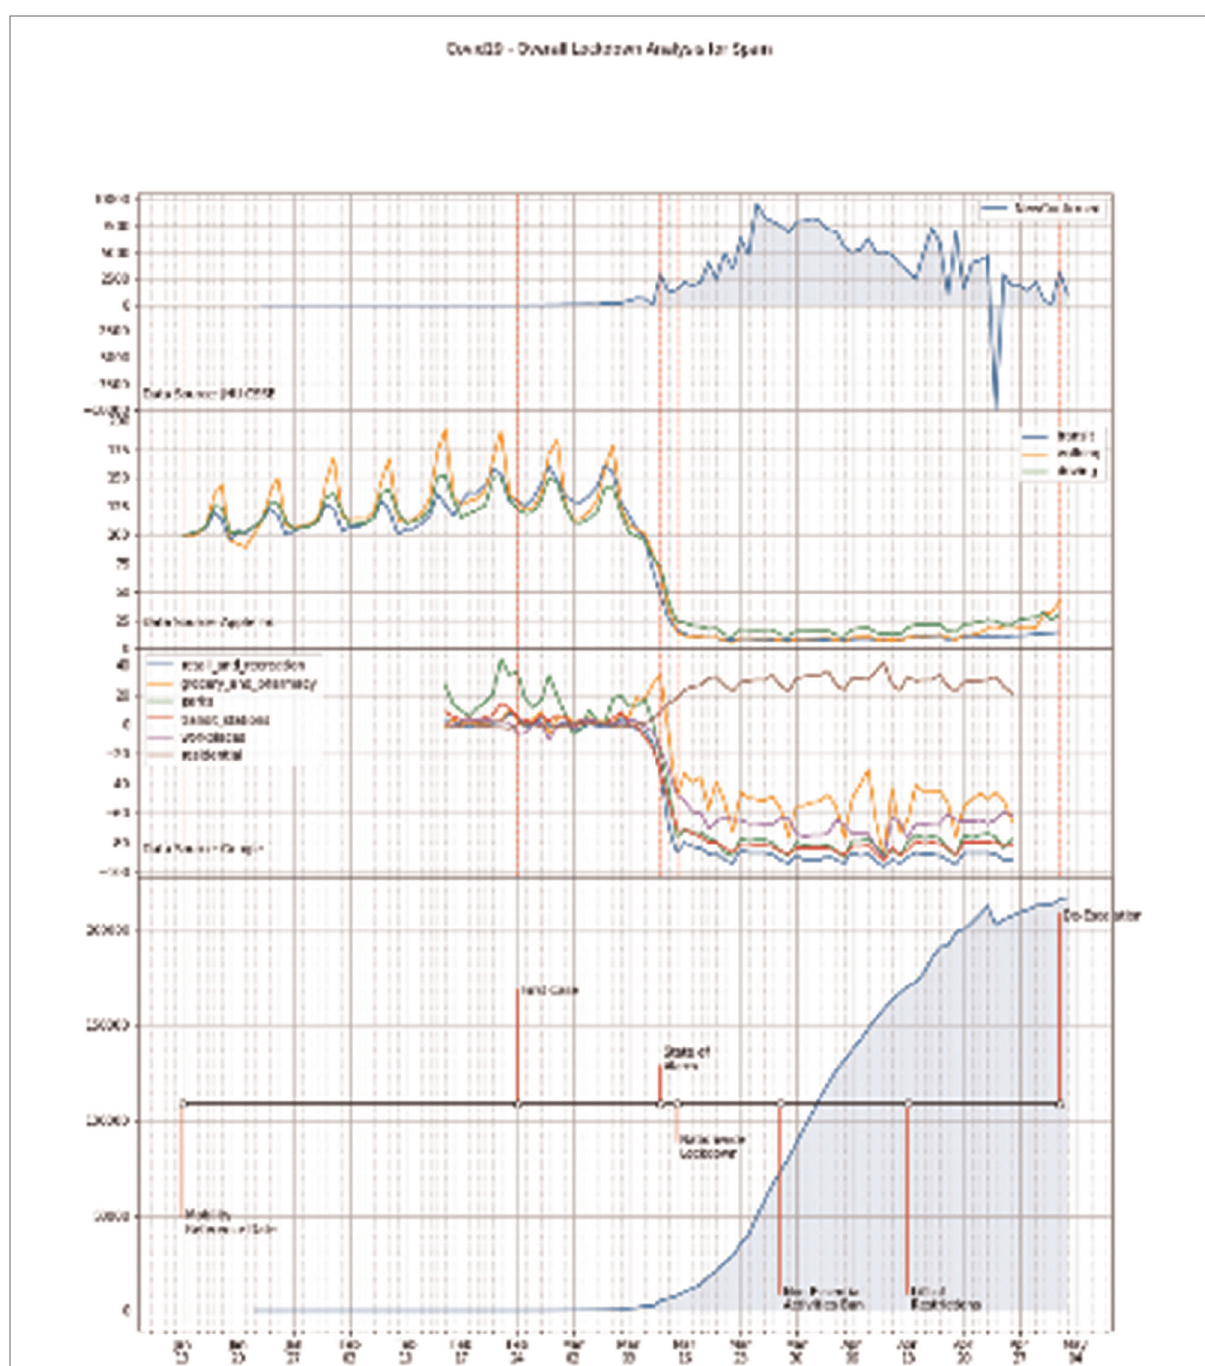
FIGURE 12 Overall lockdown analysis. Countries: Spain and Italy, top and bottom panels,